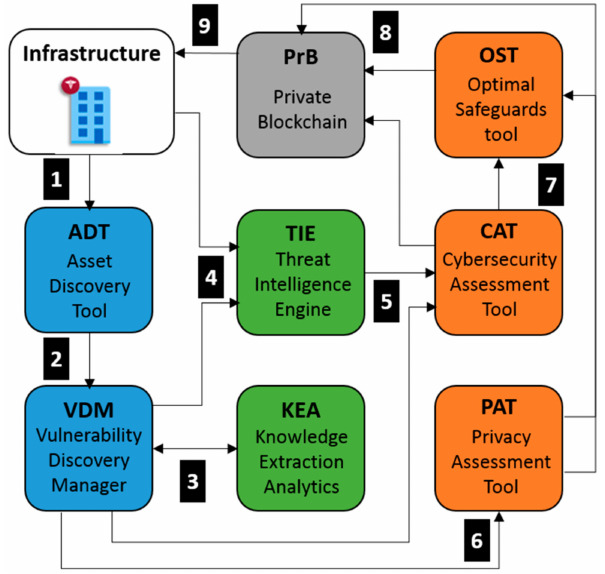
Figure 4. Interaction between CUREX’s tools with regards the infrastructure where they have been